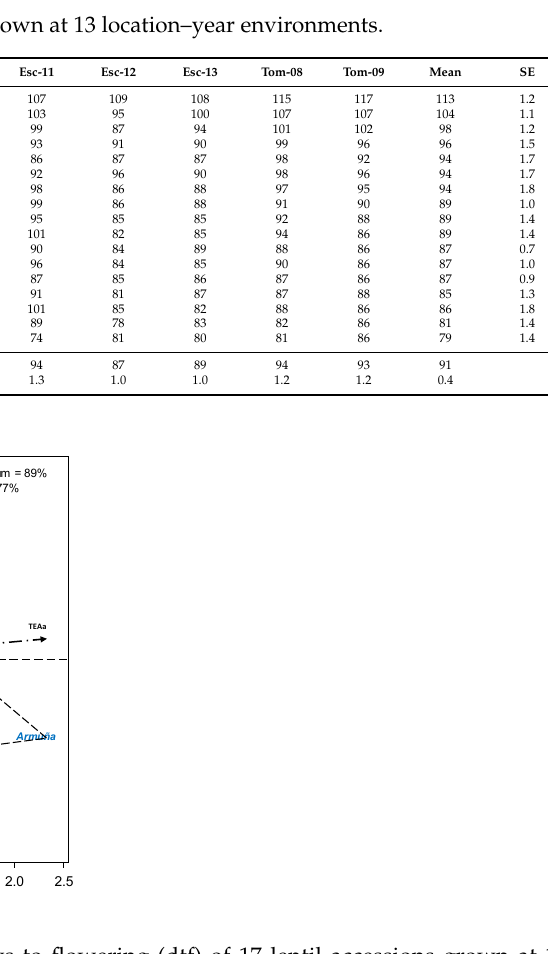
Figure 1. HA-GGE biplot based on the seed yield (kg/ha) of 17 lentil accessions grown at 13 field-year environments, from 2008 to 2013.